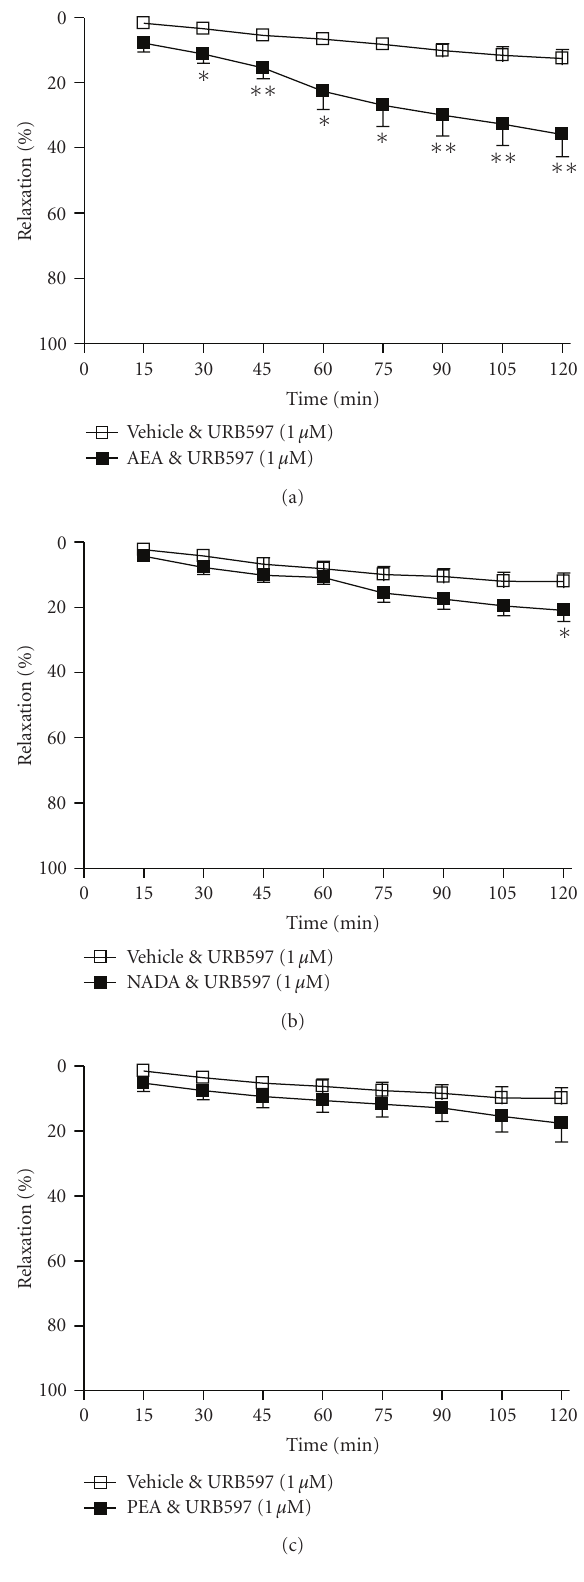
Figure 5: The e ff ects of the FAAH inhibitor, URB597 (1 μ M) on vasorelaxation to (a) anandamide, (b) NADA, and (c) PEA. Data are given as means with error bars representing SEM. ( ∗ P < . 05, ∗∗ P < . 01, Student’s t